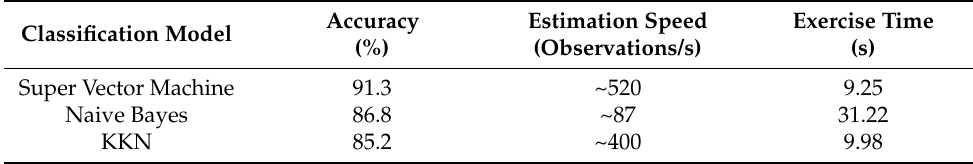
Table 6. Comparative analysis of training results.